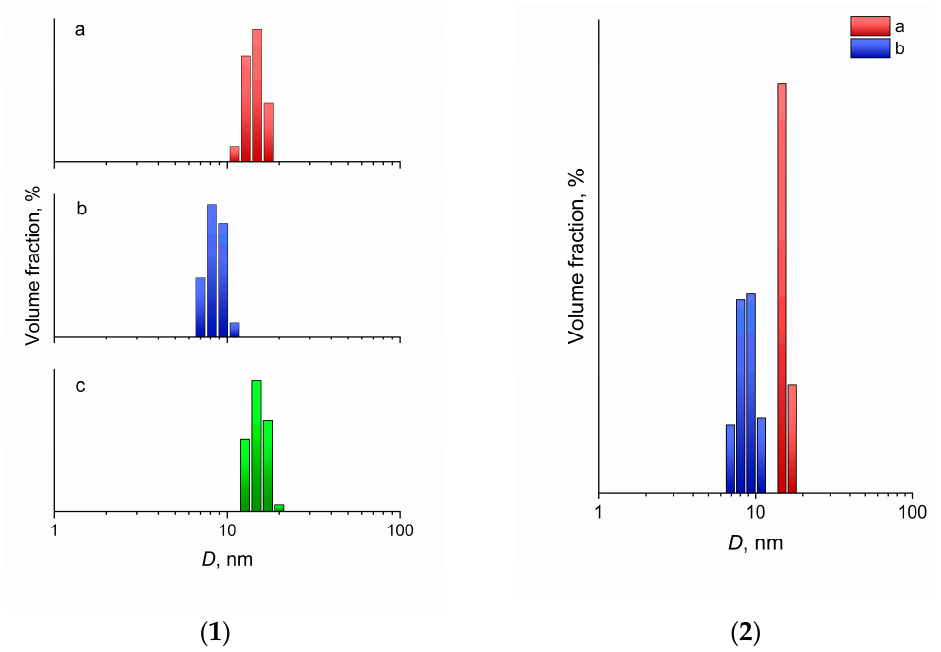
Figure 3. ( 1 ) Hydrodynamic diameter distributions, as measured using DLS, for ceria nanoparticles in hexane stabilized by ( a ) 2-ethylhexanoic acid, ( b ) octanoic acid, and ( c ) the initial aqueous ceria sol as a reference. ( 2 ) Dynamic light scattering results for the same sols after drying, followed by re-dispersion in heptane.